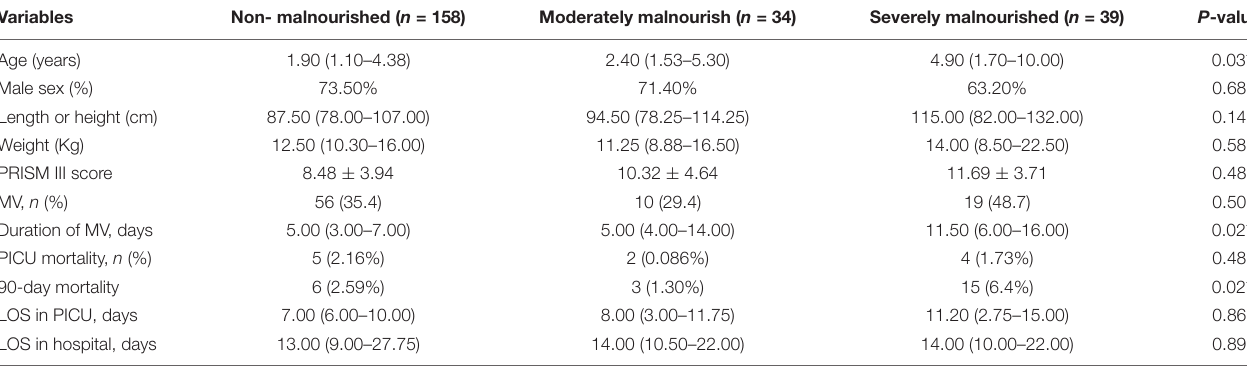
TABLE 1 | Comparison of general characteristics, clinical outcomes among the different nutrition status groups ( n = 231). Variables